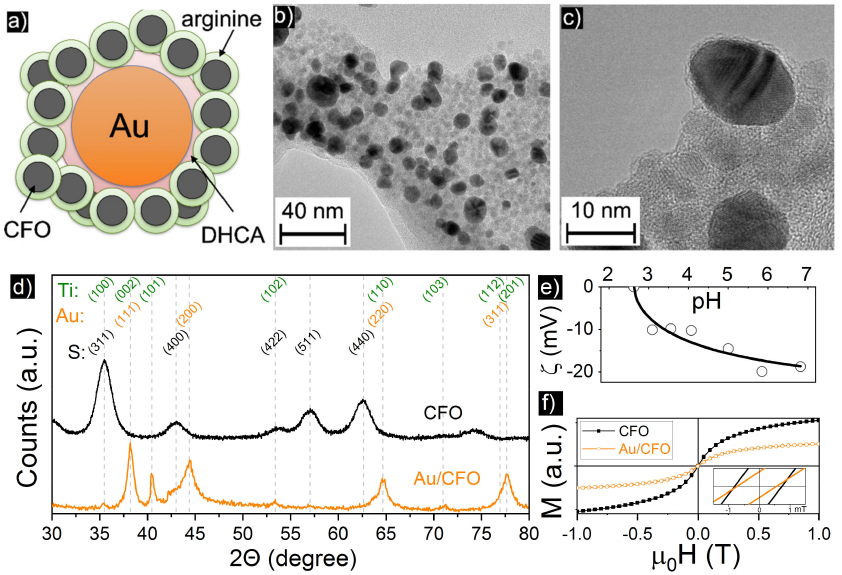
Figure 1. ( a ) Schematic representation of a gold sphere covered with arginine and surrounded with CFO nanoparticles covered with dihydrocaffeic acid; ( b , c ) TEM images of the Au/CFO composite; ( d ) XRD spectra for CFO nanoparticles [48] and Au/CFO composite. Reflections corresponding to titan (Ti), gold (Au) and spinel (S) phases are indexed; ( e ) zeta potential for CFO nanoparticles covered with dihydrocaffeic acid; ( f ) M-H loops for CFO nanoparticles and CFO \ Au composite recorded at 300